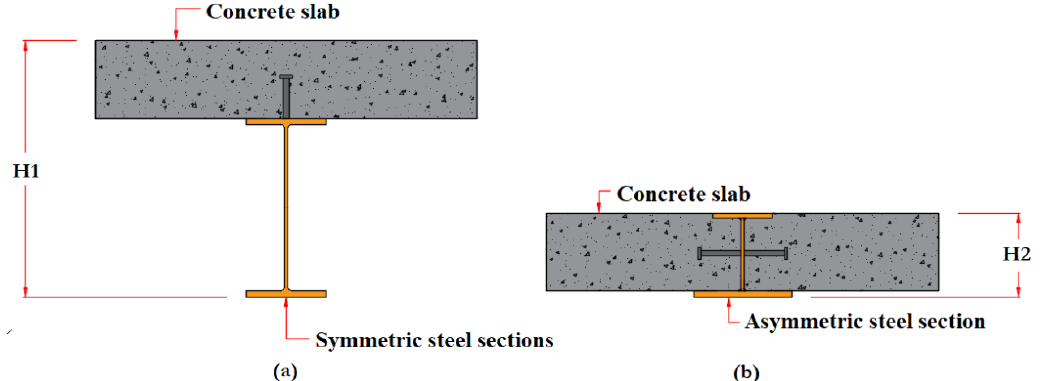
Fig. 1: Composite beam section – (a) conventional composite beam; (b) composite slim